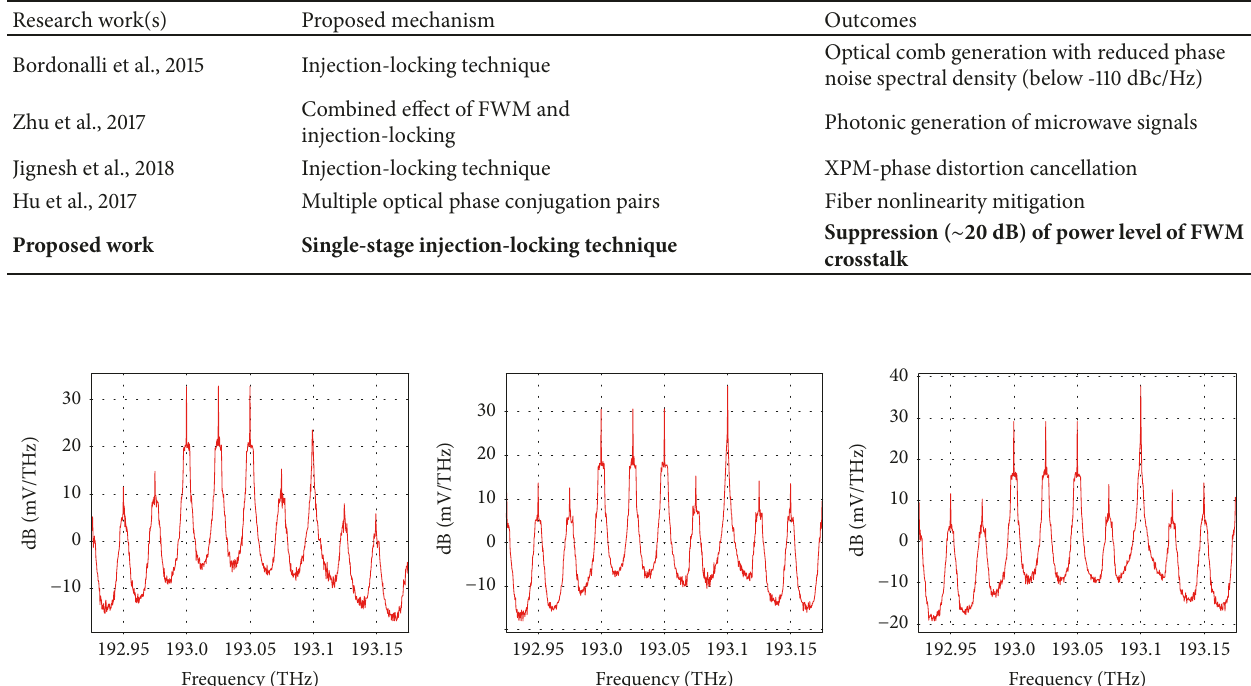
Table 2: Critical analysis of the proposed technique with respect to existing literature.